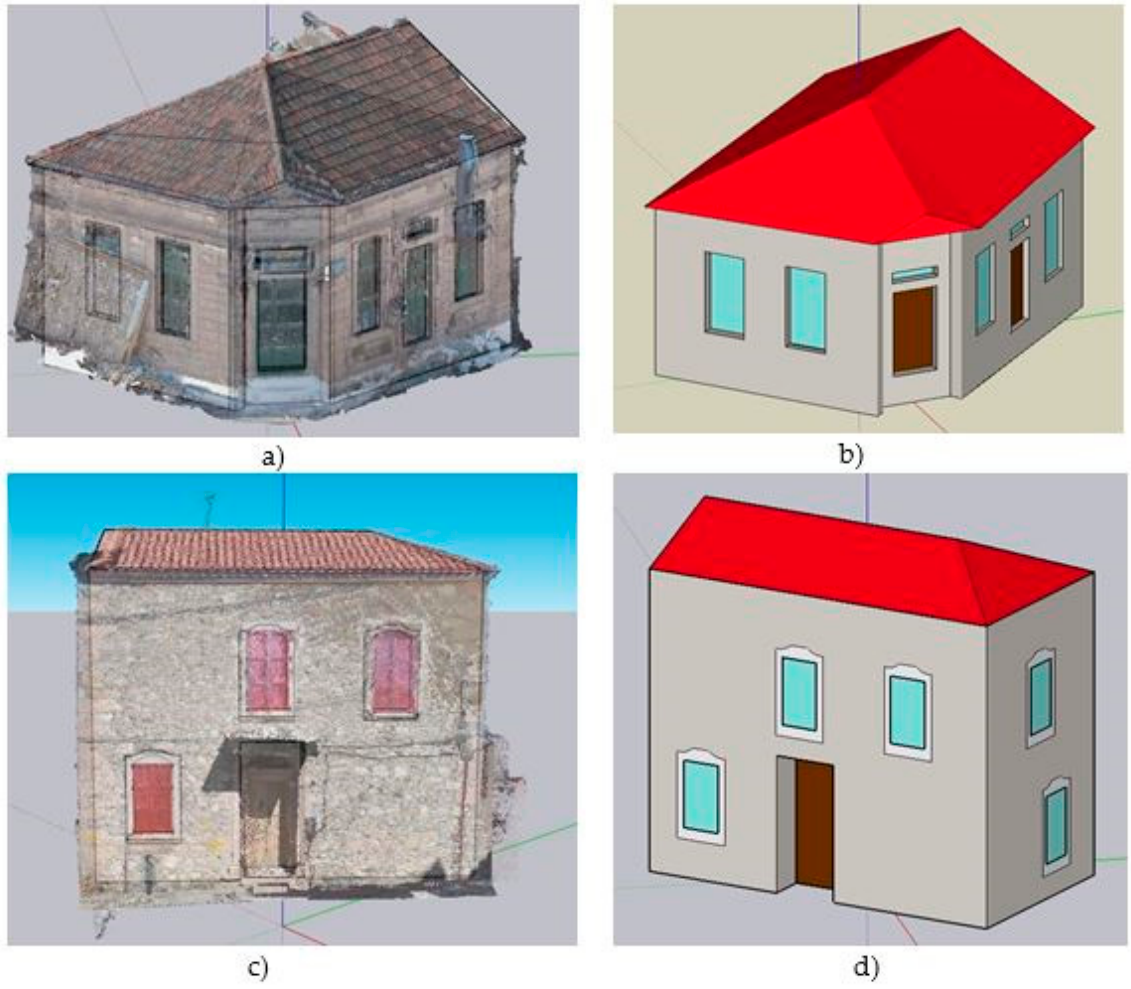
Figure 4. Three-dimensional building model generation: ( a ) point cloud of building A, ( b ) LOD3 model of building A designed in SketchUp, ( c ) point cloud of building B and ( d ) LOD3 model of building B designed in SketchUp.